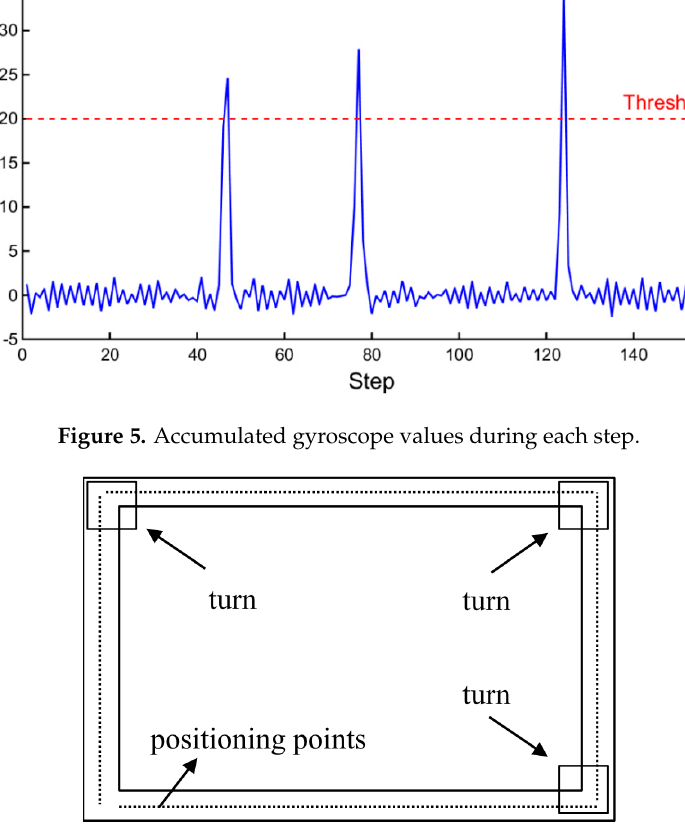
Figure 6. Turn detection. Figure 6. Turn